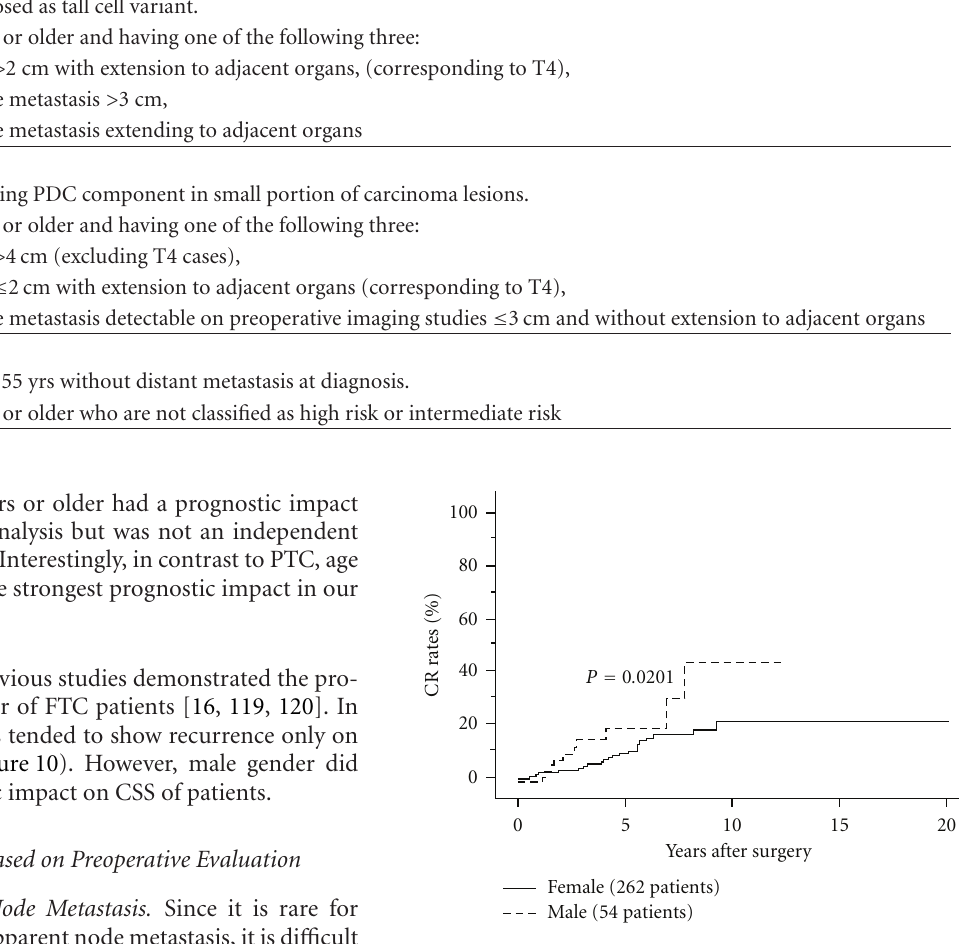
Figure 10: CR rates of female and male FTC